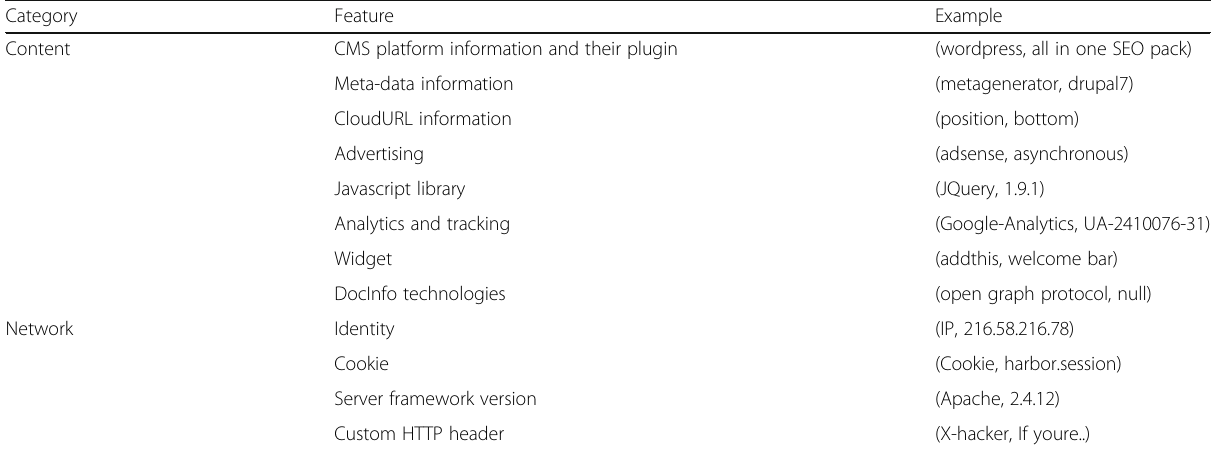
Table 2 Examples of content and network features Category